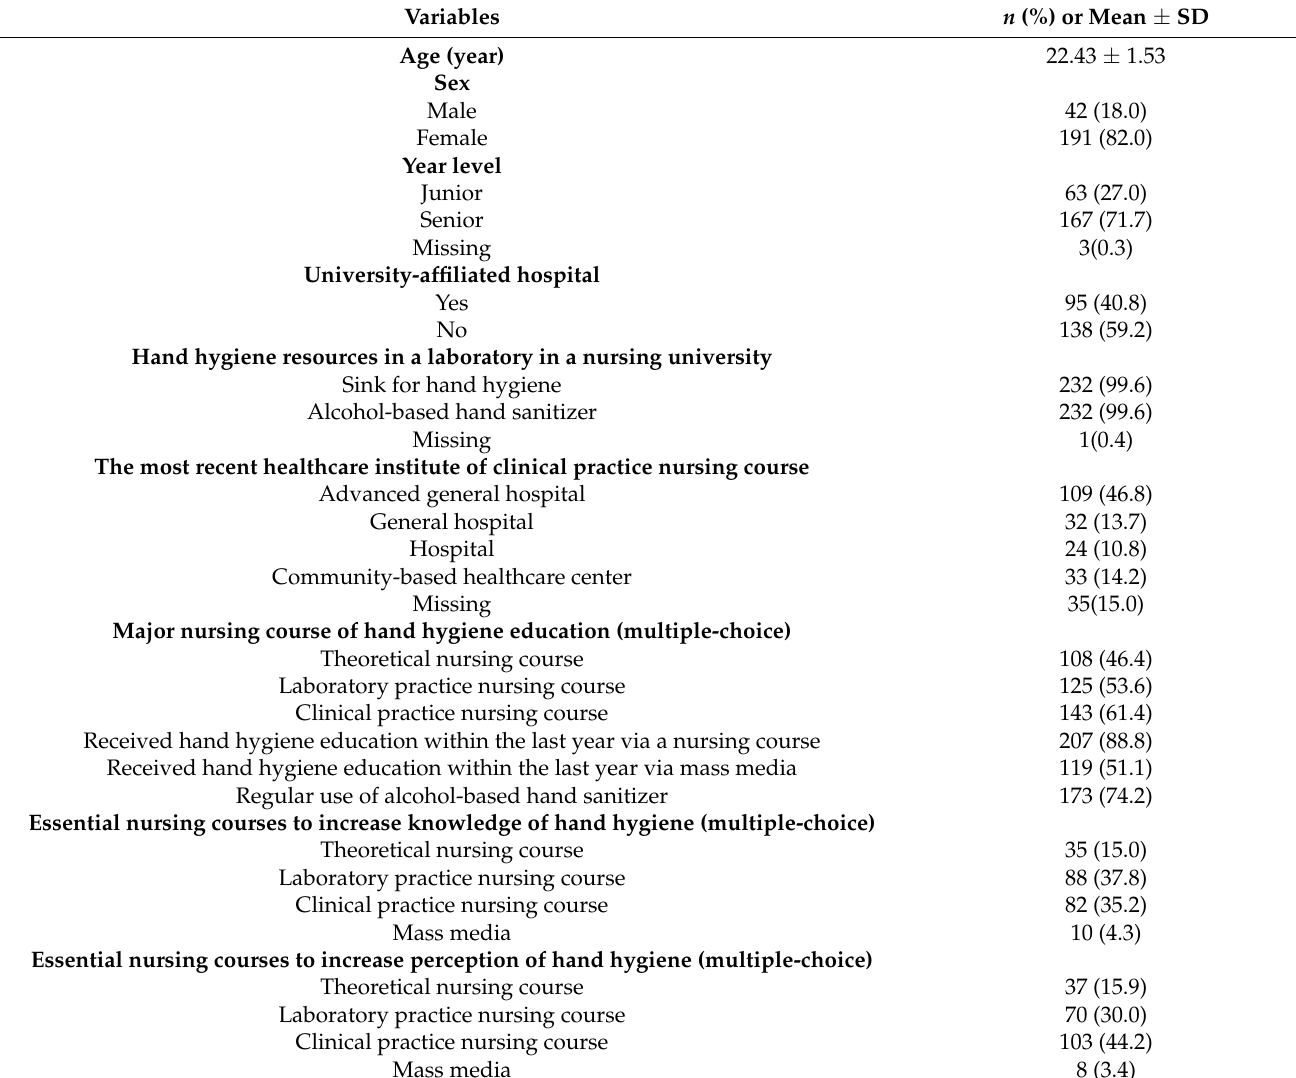
Table 1. General characteristics of participants ( n =